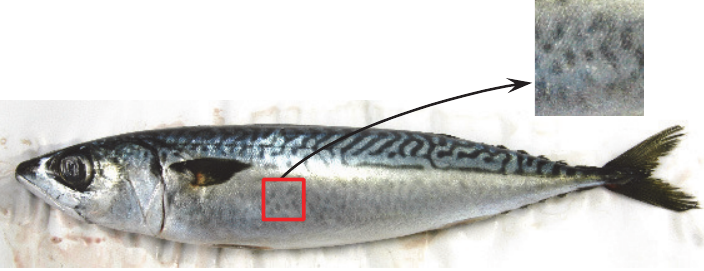
Figure 2. A mackerel that is difficult to classify. The specimen looks like S. japonicus , but has light spot patterns which is characteristic of S. australasicus .